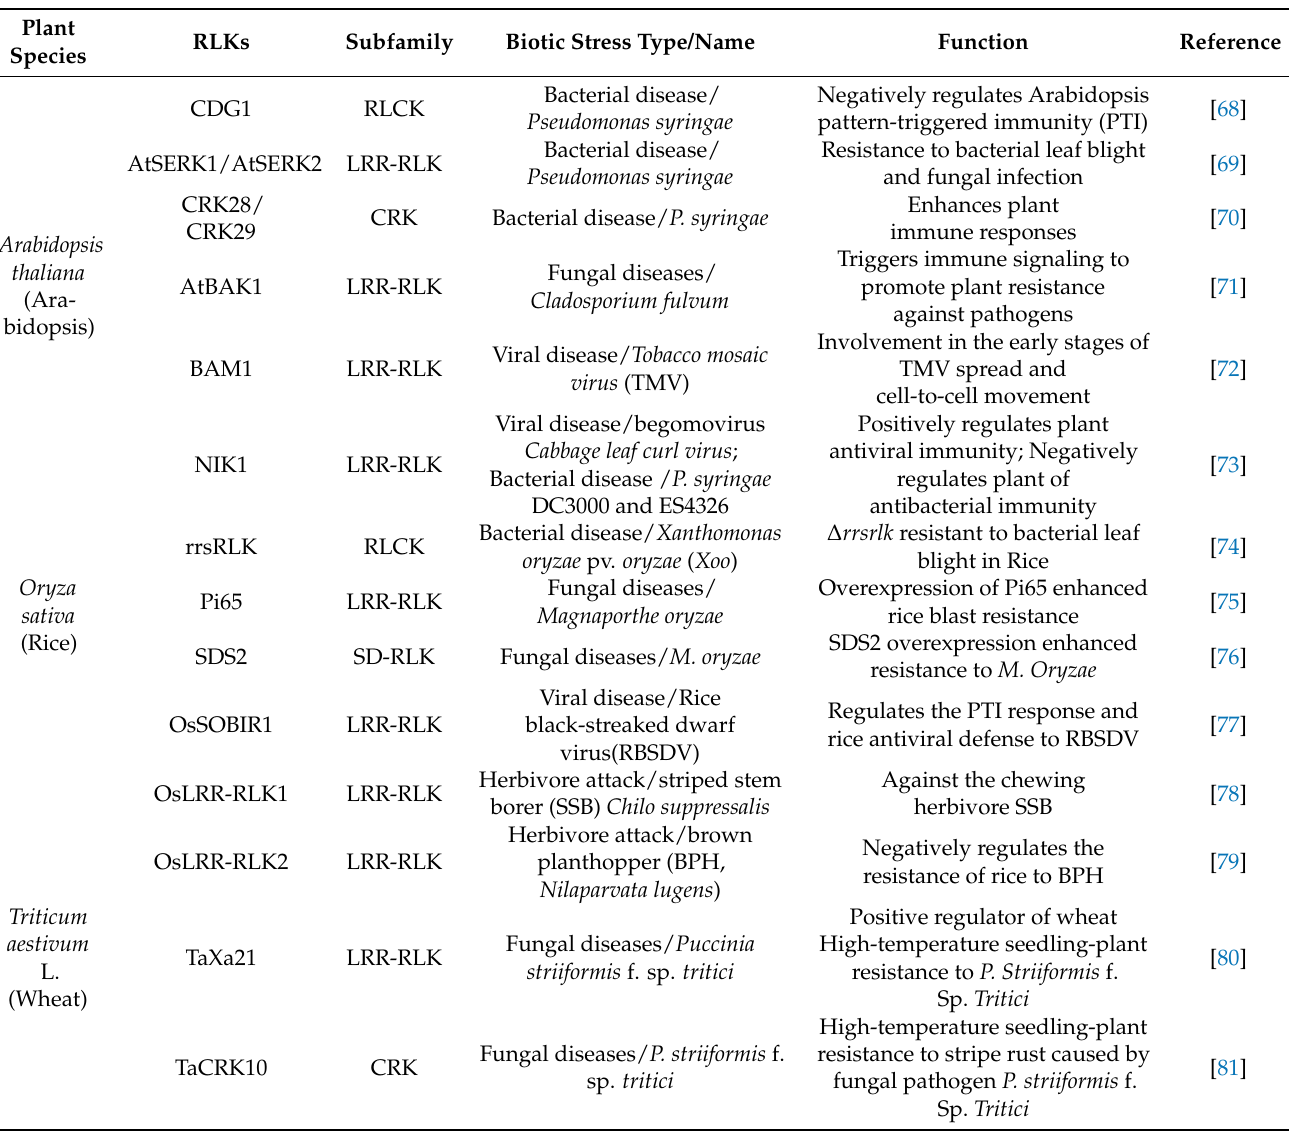
Table 3. RLKs involved in biotic stress response and their